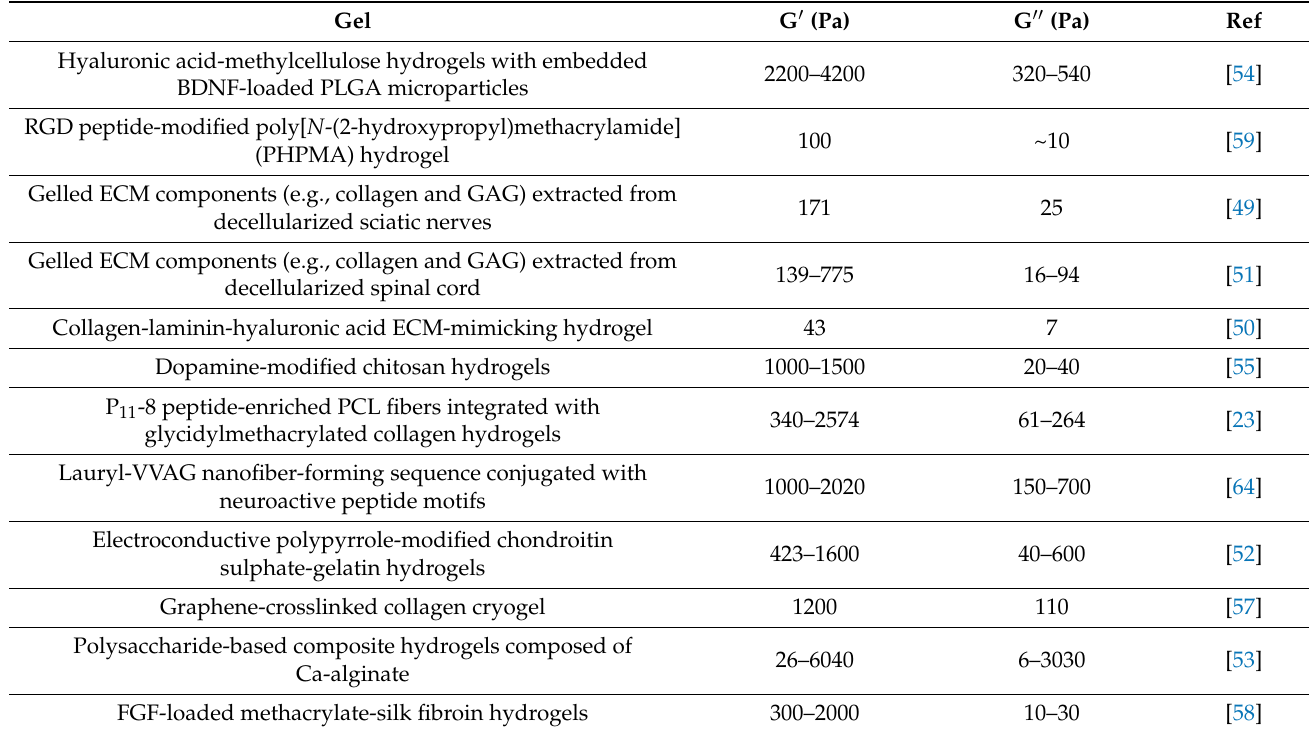
Table 3. Reported values of storage modulus (G (cid:48) ) and loss modulus (G (cid:48)(cid:48) ) for gel-based materials used for SC repair. Gel G (cid:48)